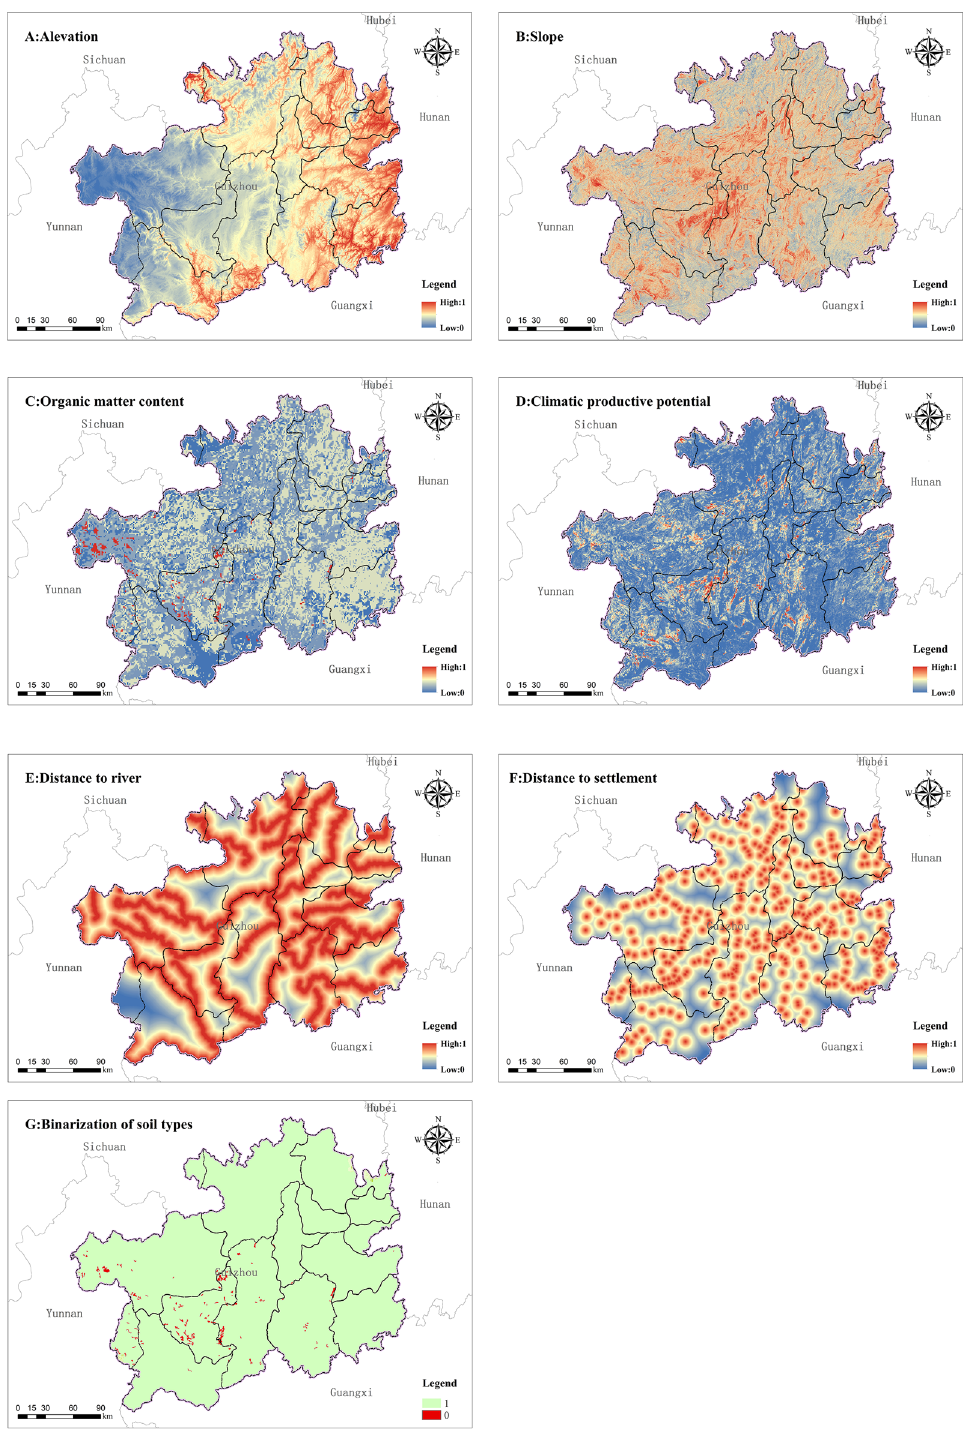
Figure 4. Spatial quantification of the arableability factor (map created using ArcGIS